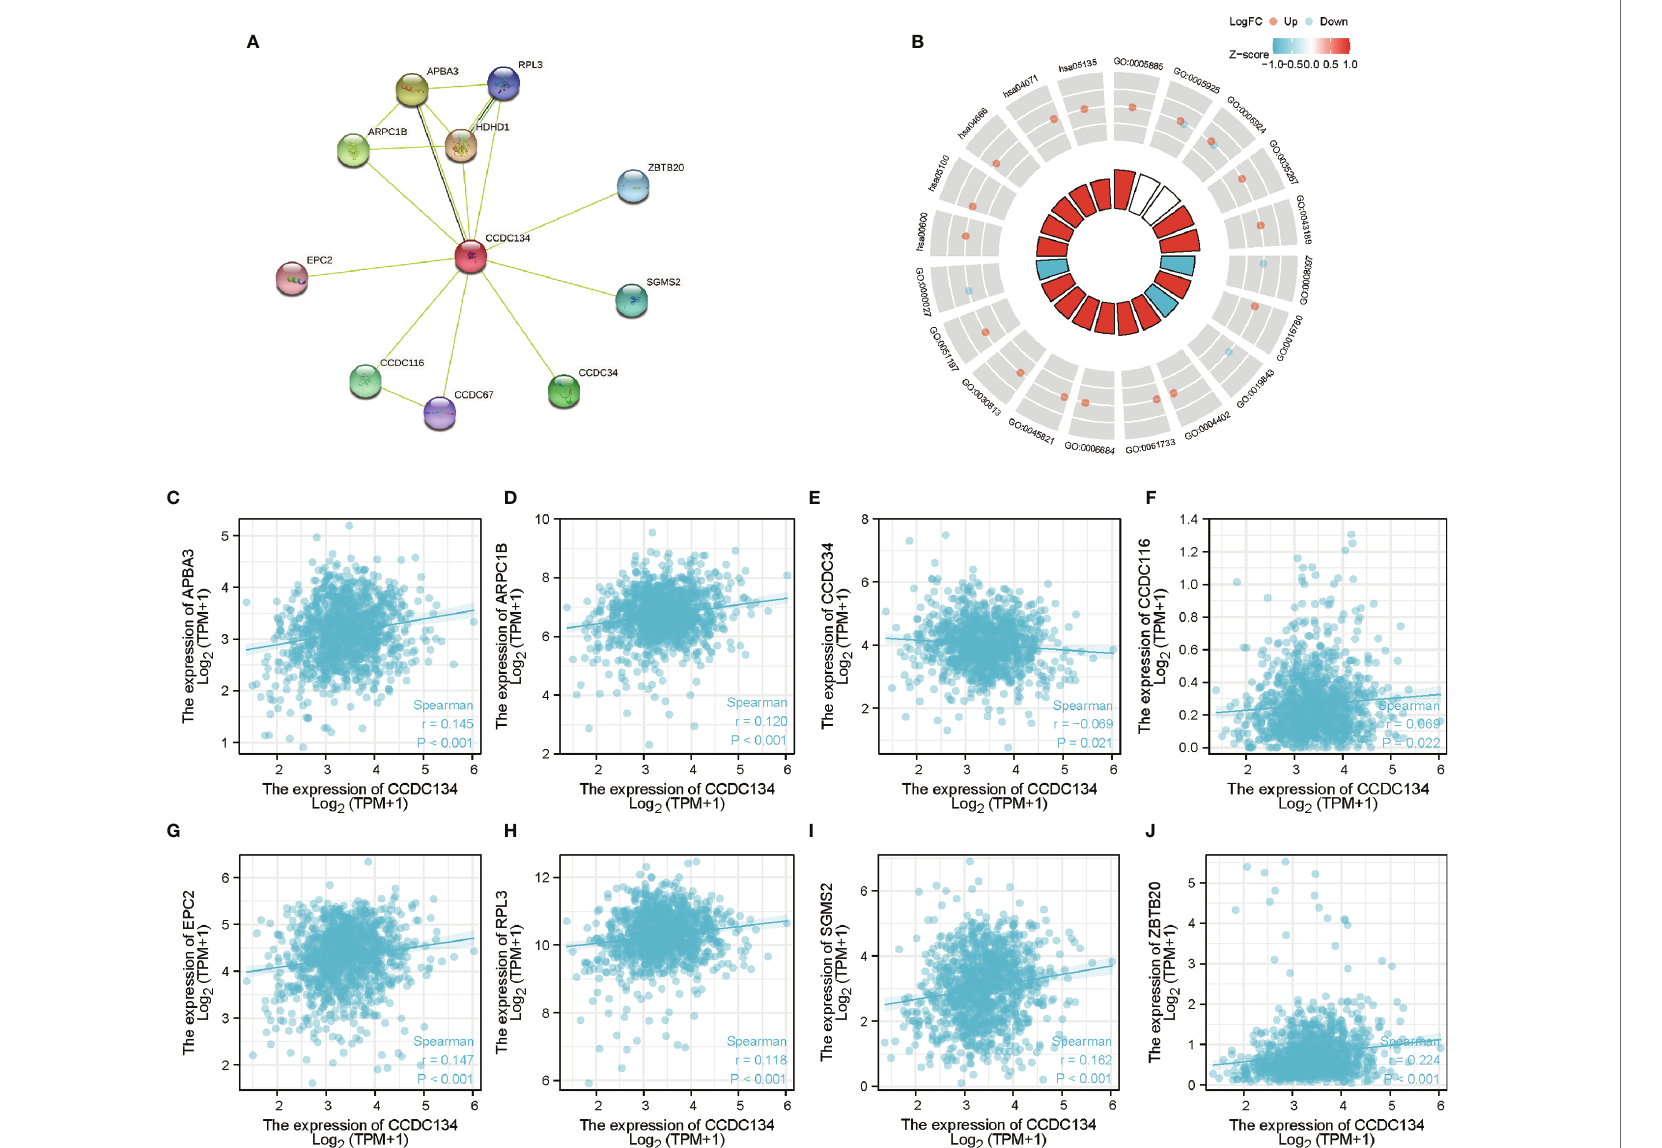
FIGURE 7 | PPI network and functional enrichment analysis. (A) CCDC134 and its co-expressed gene network. (B) Functional enrichment analysis of co-expressed genes. (C – J) The correlation analysis of CCDC134 expression and co-expressed